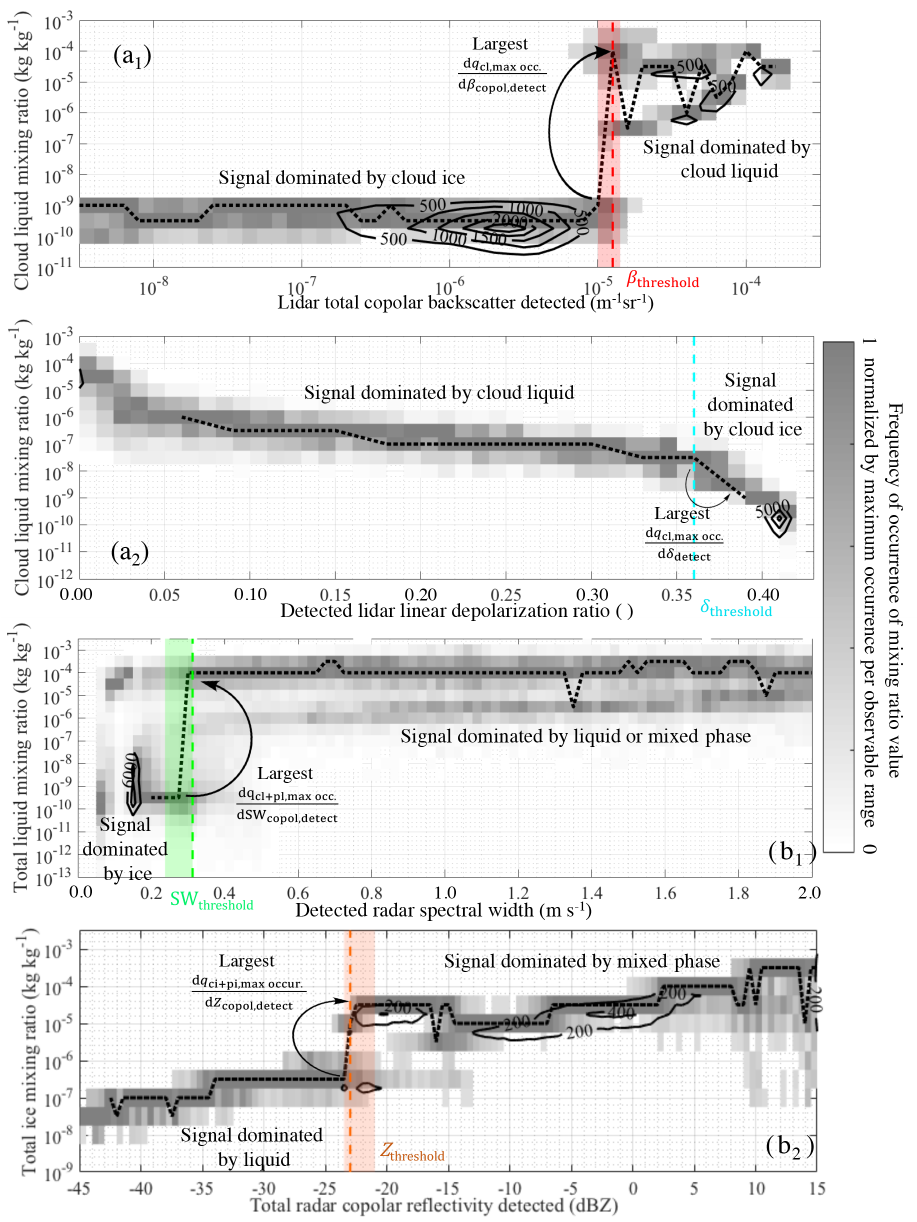
Figure 6. Example of joint frequency of occurrence histograms (contours) and normalized subsets from the joint histograms (gray shading) for one (GO) 2 -SIM forward realization: (a 1 ) β copol , total , detect , (a 2 ) δ detect , (b 1 ) SW copol , detect , and (b 2 ) Z copol , total , detect . These are used for the determination of objective water-phase classifier thresholds (vertical colored dashed lines) that are set at the observational value with the largest change (see curved arrows) in most frequently occurring mixing ratio. These thresholds are not fixed but rather reestimated for each forward-ensemble member. The widths of the color-shaded vertical columns represent the interquartile range spreads generated from 576 different forward